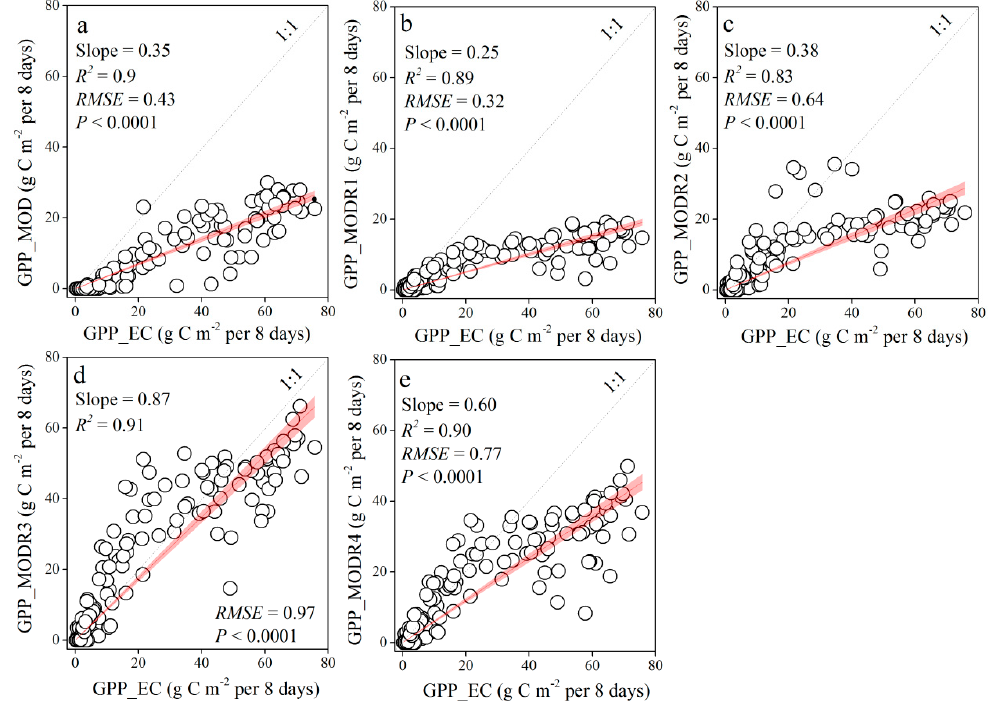
Figure 4. Linear regression between EC-based GPP estimation (GPP_EC) and MODIS-based GPP estimation. GPP estimations based on the MOD17A2 algorithm are showed in Table 1. ( a ), GPP_MOD; ( b ), GPP_MODR1; ( c ), GPP_MODR2; ( d ), GPP_MODR3; ( e ), GPP_MODR4. Data are the 8 days composited GPP values. The solid lines are the regression curves, the coverages are 95% confidence interval of linear regressions. Dash lines are the 1:1 reference lines.